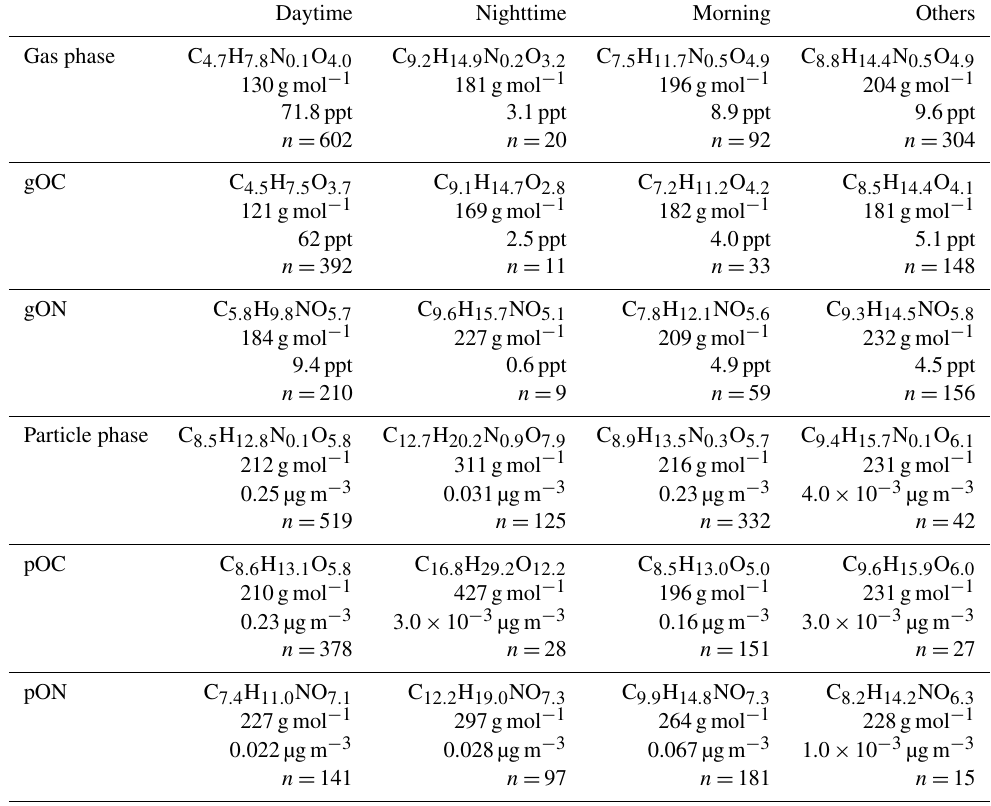
Table 1. Effective molecular compositions, molecular weights, mixing ratio or mass concentration, and number of species belonging to the four subgroups (daytime, nighttime, morning, and others) of gas-phase organic nitrates (gON = C x H y NO z ), gas-phase organic carbon (gOC = C x H y N 0 O z ), particulate organic nitrates (pON), and particulate organic carbon (pOC). Corresponding effective statistics for all gas- phase products (gON and gOC) and particle-phase products (pON and pOC) are also shown. The campaign-median mixing ratio of gOC is 62ppt, which given its effective molecular weight of 121gmol − 1 is about 0.3µgm − 3